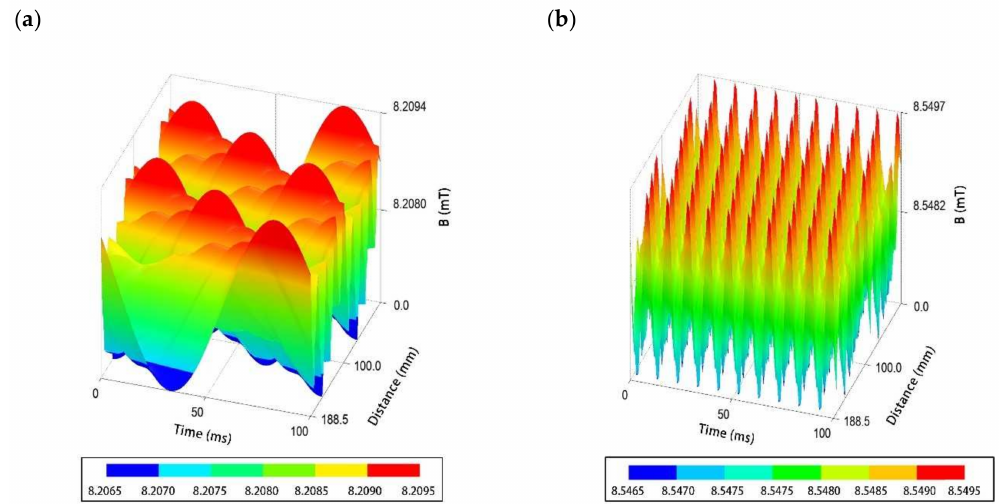
Figure 5. Changes in magnetic flux characteristic depending on the applied AC frequency: ( a ) 5 Hz; ( b ) 50